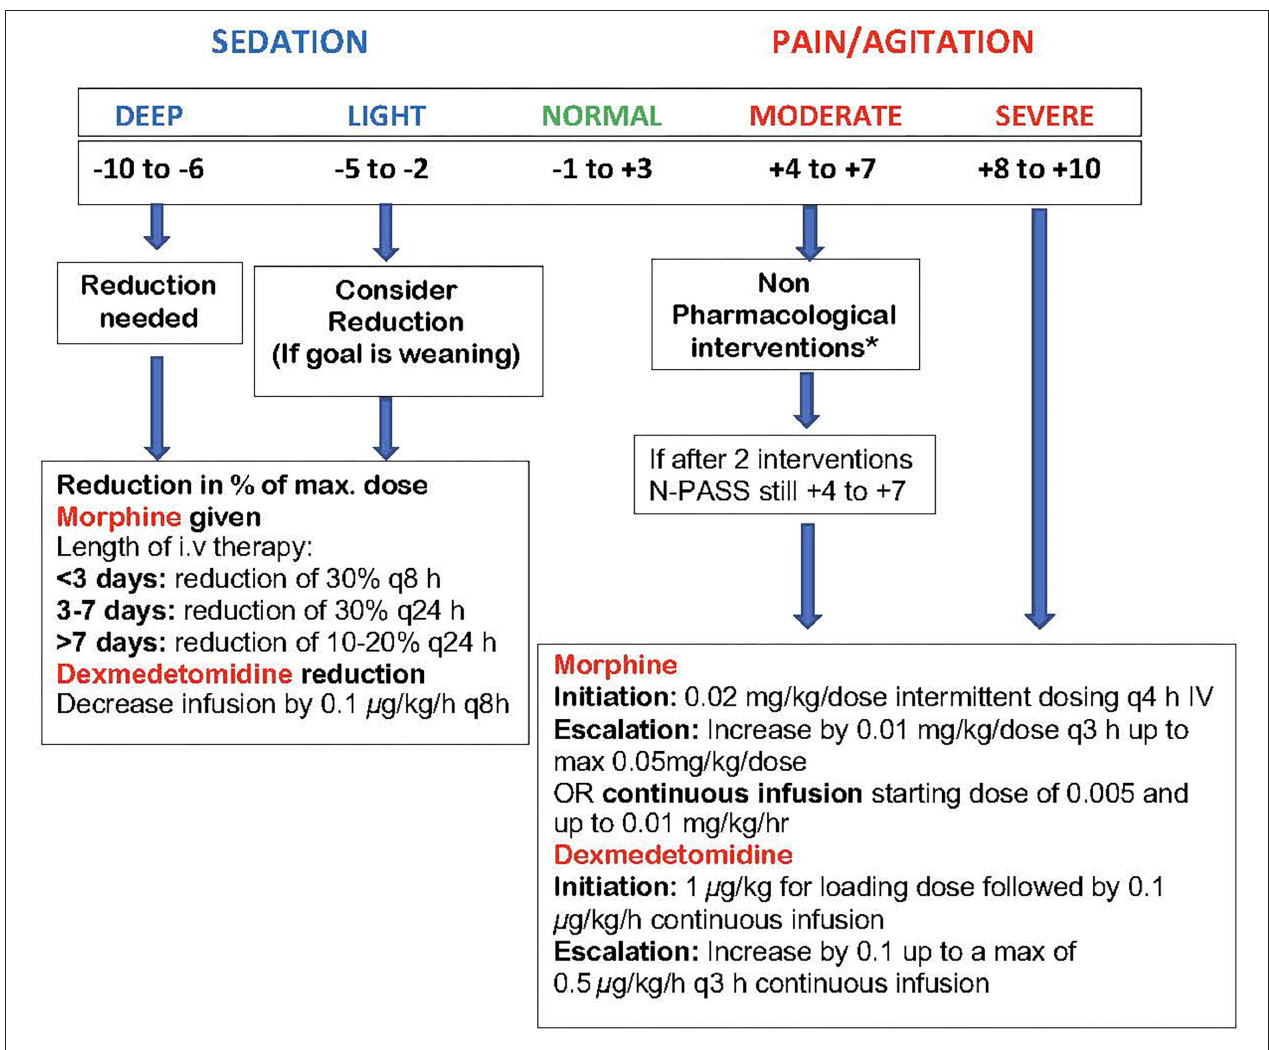
FIGURE 2 | DICE trial N-PASS Assessment for Pain, Agitation and Sedation. Performed every 3h and after 30min post escalation or de-escalation of medication. The N-PASS tool uses 5 assessment criteria (crying/irritability, behavior/state, facial expression, extremities/tone, and vital signs); each criterion is graded 0, − 1, or − 2 for sedation and 0, 1, or 2 for pain/agitation. · N-PASS score > 3 (significant pain or agitation) = supplemental sedation or analgesia therapy considered. · N-PASS score > 8 = initiate/escalate therapy. · N-PASS score < -2 (light sedation) = consider therapy weaning. · N-PASS score < -5 = weaning warranted. * Non-Pharmacological Interventions (maybe limited during hypothermia): Nonnutritive sucking, swaddling, change of position, Kangaroo